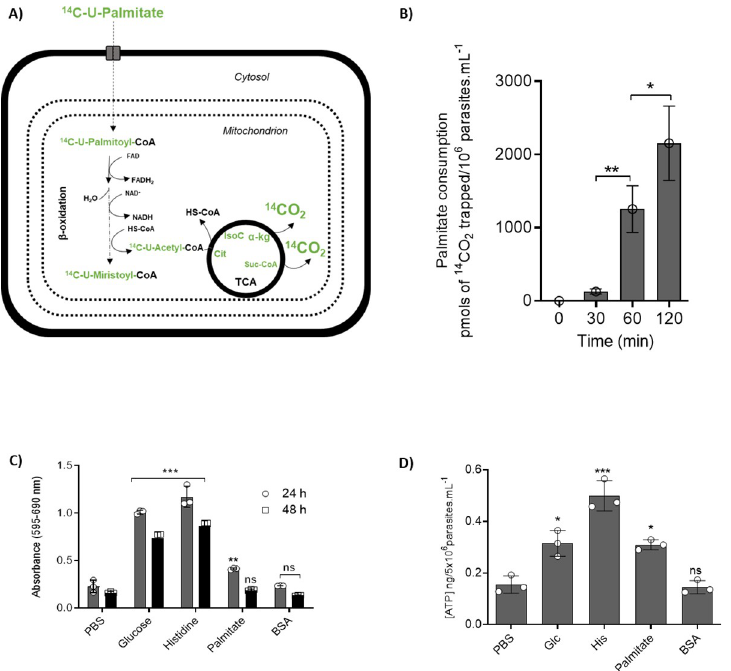
Fig 1. Palmitate oxidation promotes ATP production and viability in epimastigote forms under starvation. A) Schematic representation of 14 C-U-palmitate metabolism. The metabolites corresponding to labelled palmitate metabolism are presented in green. B) 14 CO 2 production from epimastigotes incubated in PBS with 14 C-U-palmitate 100 μ M. The 14 CO 2 was captured at 0, 30, 60 and 120 min. C) Viability of epimastigote forms after incubation with different carbon sources and palmitate. The viability was assessed after 24 and 48 h by MTT assay. D) The intracellular ATP content was evaluated following incubation with different energy substrates or not (PBS, negative control). The ATP concentration was determined by luciferase assay and the data were adjusted by the number of cells. A statistical analysis was performed with one-way ANOVA followed by Tukey’s post-test at p < 0.05 using the GraphPad Prism 8.0.2 software program. We represent the level of statistical significance in this figure as follows: ��� p value < 0.001; �� p value < 0.01; � p value < 0.05. For a p value > 0.05 we consider the differences to be not significant (ns).